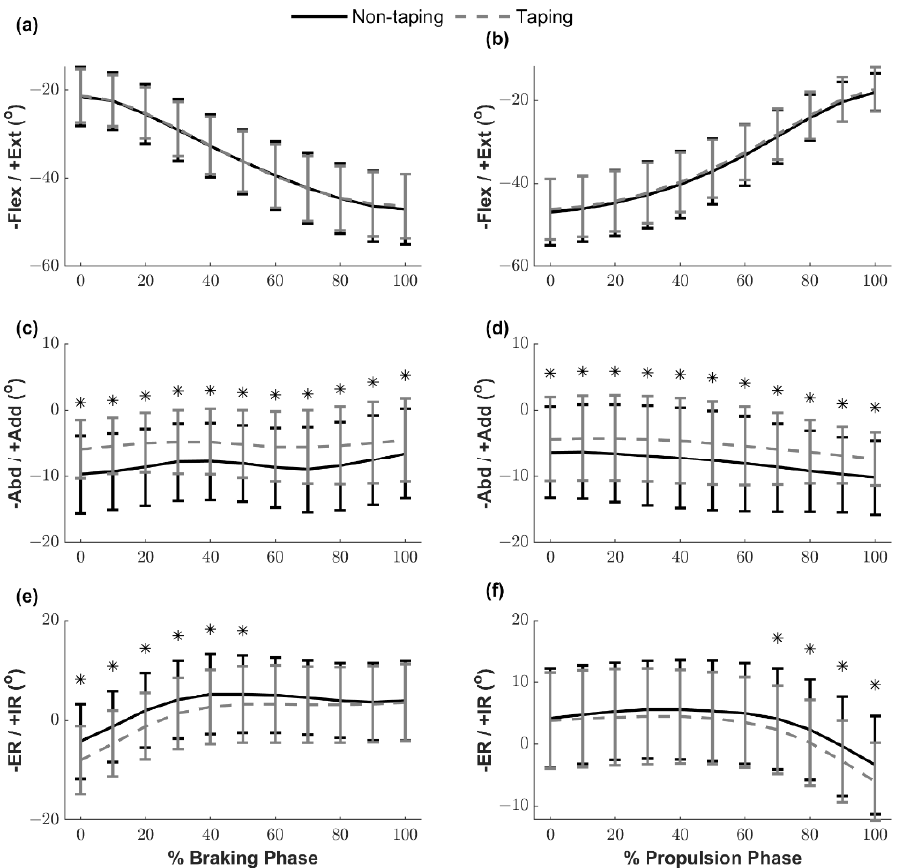
Figure 5. Knee joint angle ensemble curves of the braking and propulsion phases, shown for 10% increments. ( a ) Knee flexion/extension angle in the braking phase; ( b ) knee flexion/extension angle in the propulsion phase; ( c ) knee abduction/adduction angle in the braking phase; ( d ) knee abduction/adduction angle in the propulsion phase; ( e ) knee external rotation/internal rotation angle in the braking phase; ( f ) knee external rotation/internal rotation angle in the propulsion phase. * Significant differences between the conditions. Flex/Ext: flexion/extension; Abd/Add: abduction/adduction; ER/IR: external rotation/internal rotation.